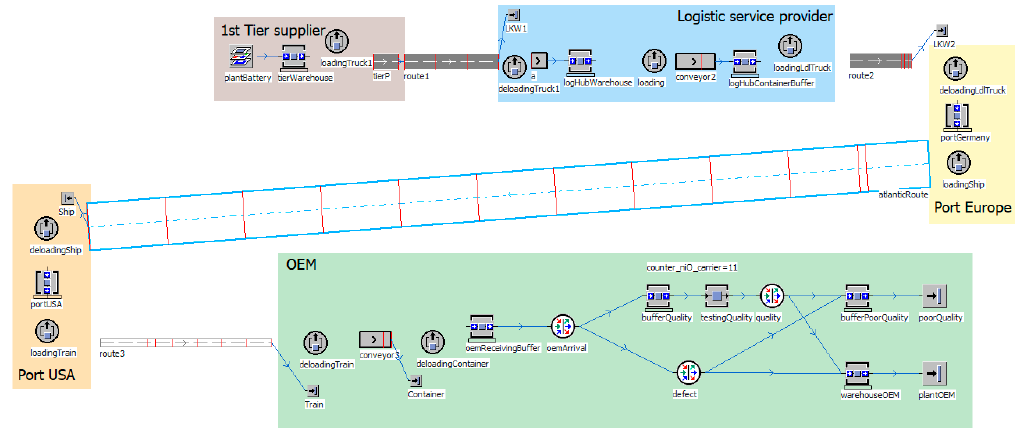
Figure 3. Simulation model in Tecnomatix Plant Simulation 14.1.